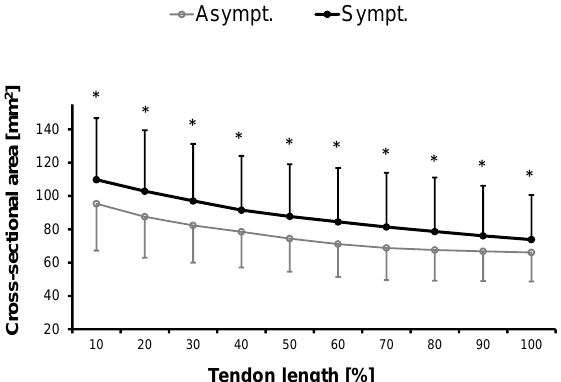
tween symptomatic and asymptomatic leg at baseline; MVC = maximum voluntary isometric plan- tar flexor muscle contraction; CSA (mean) = averaged cross-sectional area of Achilles tendon; Vasc. = vascularity; intratend. = intratendinous; overall = intratendinous and paratendinous vasculariza- tion; Impulse % = impulse percent of total impulse; CMJ = counter movement jump; DJ = drop jump. 3.1.1. Cross-Sectional Area The Achilles tendon CSA was significantly larger in the symptomatic compared to the asymptomatic leg along the entire length of the free tendon measured at 10% intervals (Figure 1). The mean difference between legs ± SD and the corresponding p -values for the 10% intervals were as follows: 0 – 10%: 14.4 ± 27.8 mm 2 ( p = 0.005), 10 – 20%: 15.3 ± 26.7 mm 2 ( p = 0.002), 20 – 30%: 14.7 ± 24.4 mm 2 ( p = 0.001), 30 – 40%: 13.0 ± 24.3 mm 2 ( p = 0.002), 40 – 50%: 13.3 ± 20.4 mm 2 ( p = 0.001), 50 – 60%: 13.3 ± 20.6 mm 2 ( p = 0.001), 60 – 70%: 12.6 ± 20.2